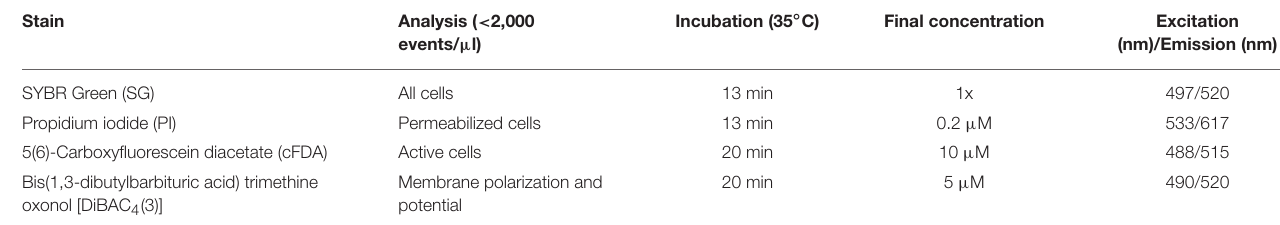
TABLE 3 | Used dyes for flow cytometer analysis, incubation times and